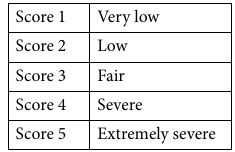
Table 1. Scoring for noise and streak artifact.